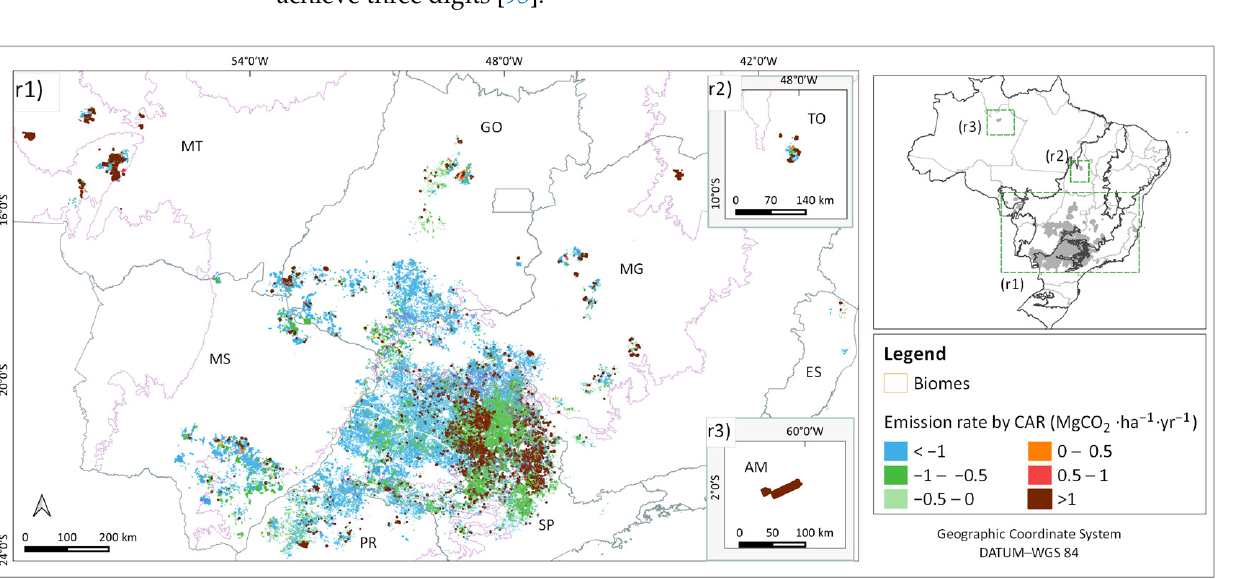
Table 3. CO 2 emission/removals due to dLUC in sugarcane cultivation areas and within associated CARs from 2000 to 2020 and the resulting carbon footprint of ethanol associated with LUC. Data are shown for each